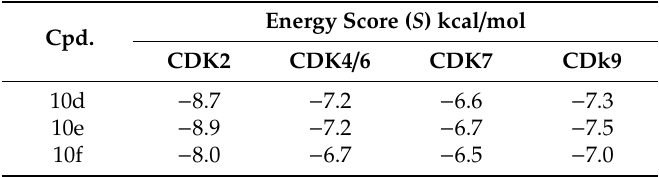
Table 4. Docking energy scores in kcal / mol ( S ) for benzimidazoles 10d – f. Energy Score ( S ) kcal / mol Cpd.